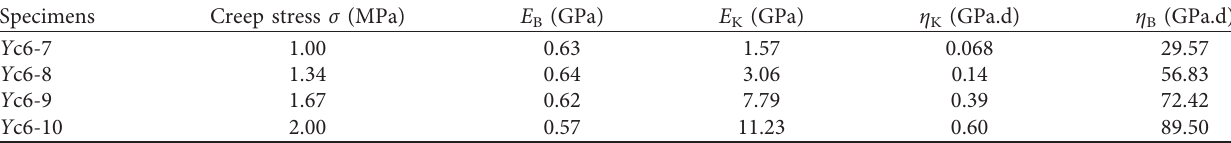
Table 5: Calculation results of creep parameters of the filling body.